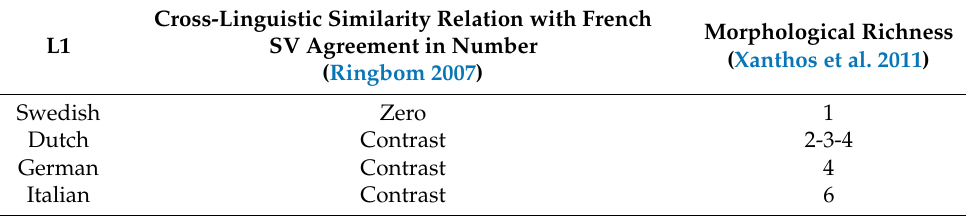
Table 1. Cross-linguistic similarity and morphological richness of the source languages. Cross-Linguistic Similarity Relation with French Morphological Richness L1 SV Agreement in Number (Xanthos et al. 2011) (Ringbom 2007) Swedish Zero 1 Dutch Contrast 2-3-4 German Contrast 4 Italian Contrast